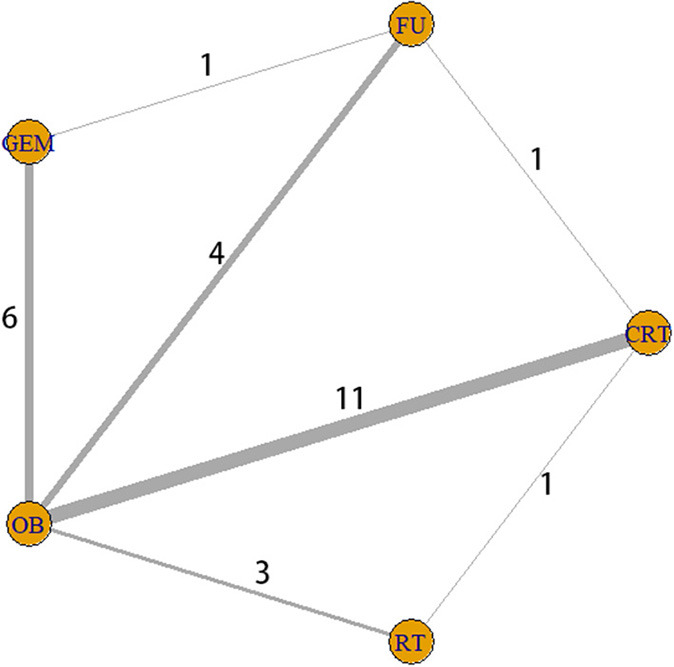
Interaction network between interventions. The five yellow circles represent five different interventions, while the thickness of the lines connecting the circles is proportional to the number of trials.